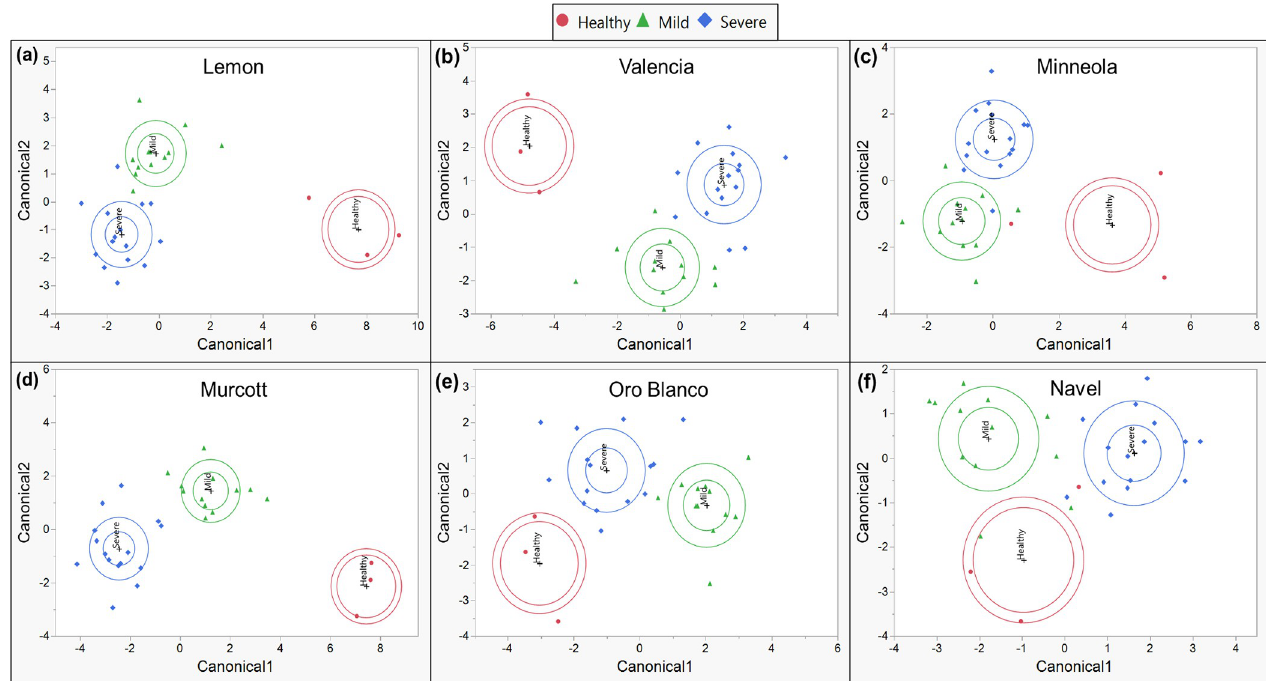
Fig 9. Canonical plots using 10 most variable individual terpenoid compounds. Canonical plots of different plants displaying mild (green-triangle), severe (blue-diamond), or no (red-circle) symptoms after CTV- or mock-inoculation, within each citrus cultivar. Canonicals were generated by stepwise discriminant analysis utilizing the 10 most variable terpenoids between differentially infected plants of each cultivar. Outer ellipses are estimated 50% of the samples within a cultivar, and inner ellipses show the 95% confidence region of cultivar means.